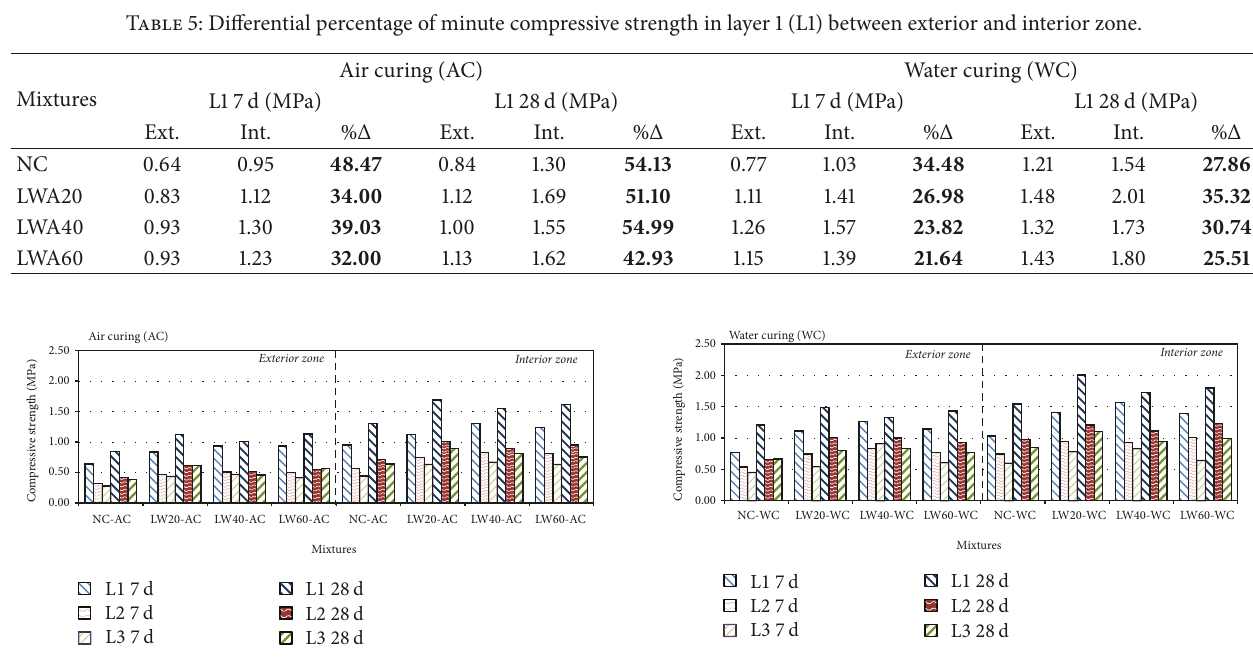
Figure 13: Minute compressive strength of NC and LWA mixtures at L1, L2, and L3 cured in the air (7 and 28 days of age).